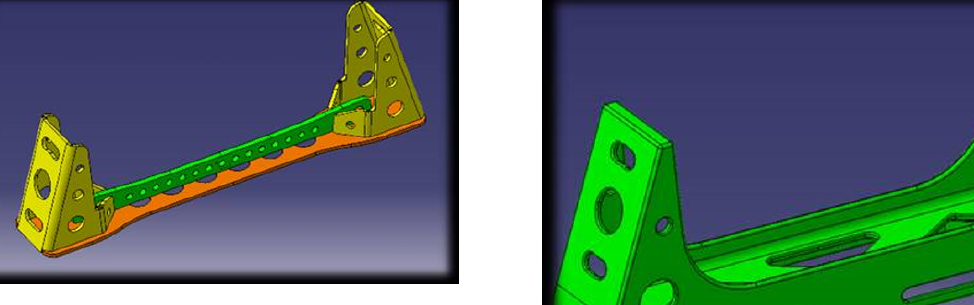
Figure 1: Front axle 2018.